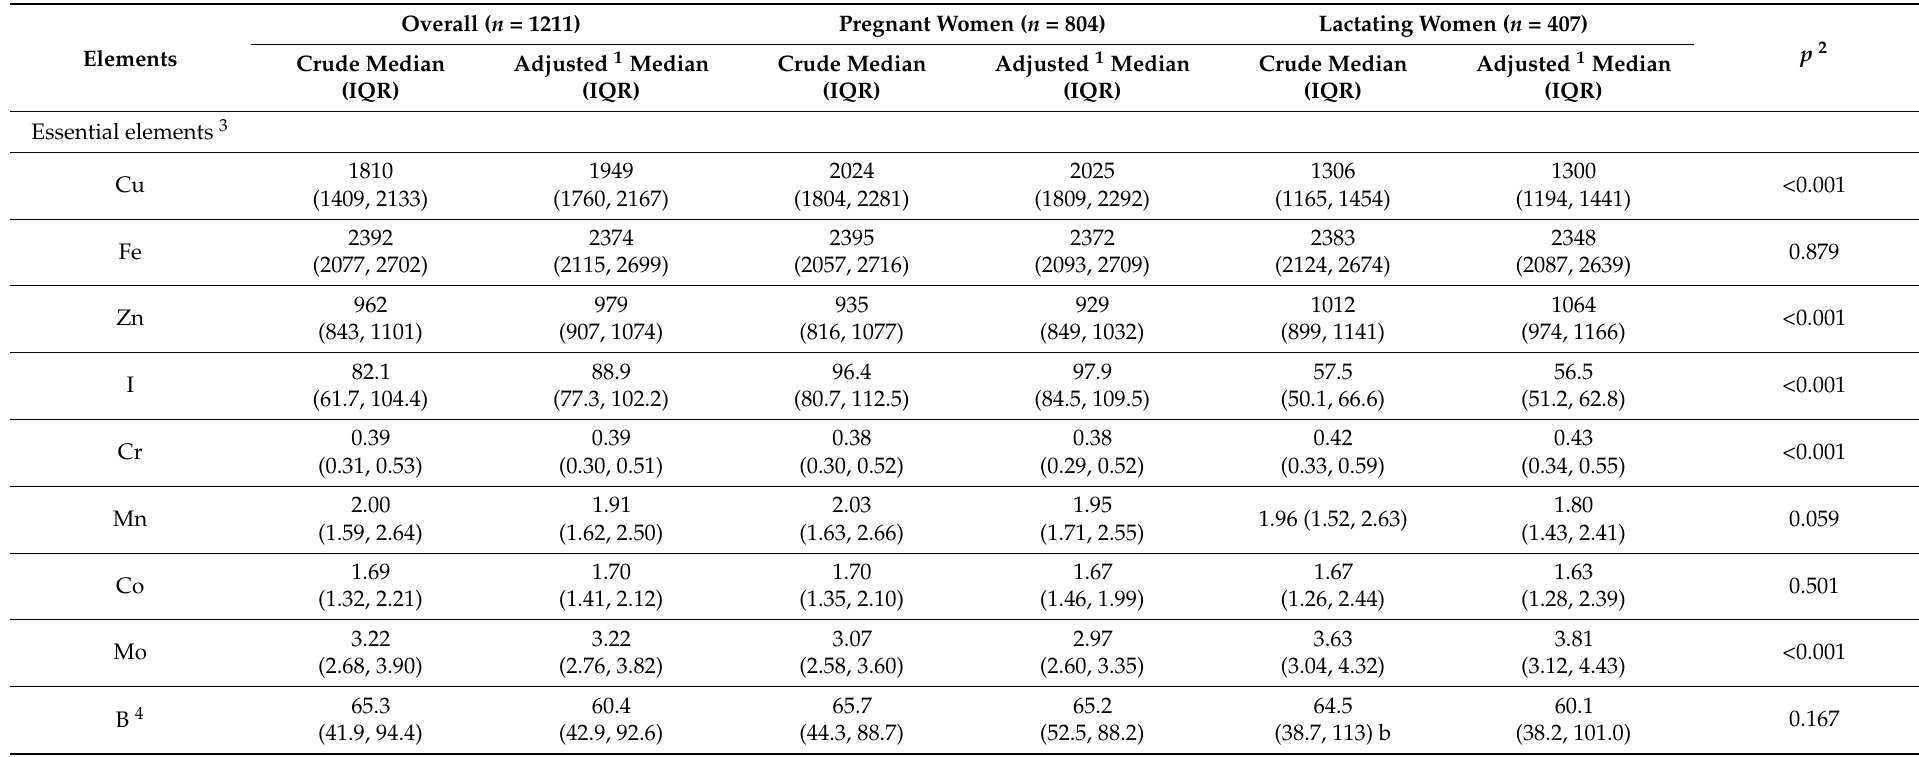
Table 1. Concentrations (ng/mL) of plasma essential and toxic elements among pregnant and lactating